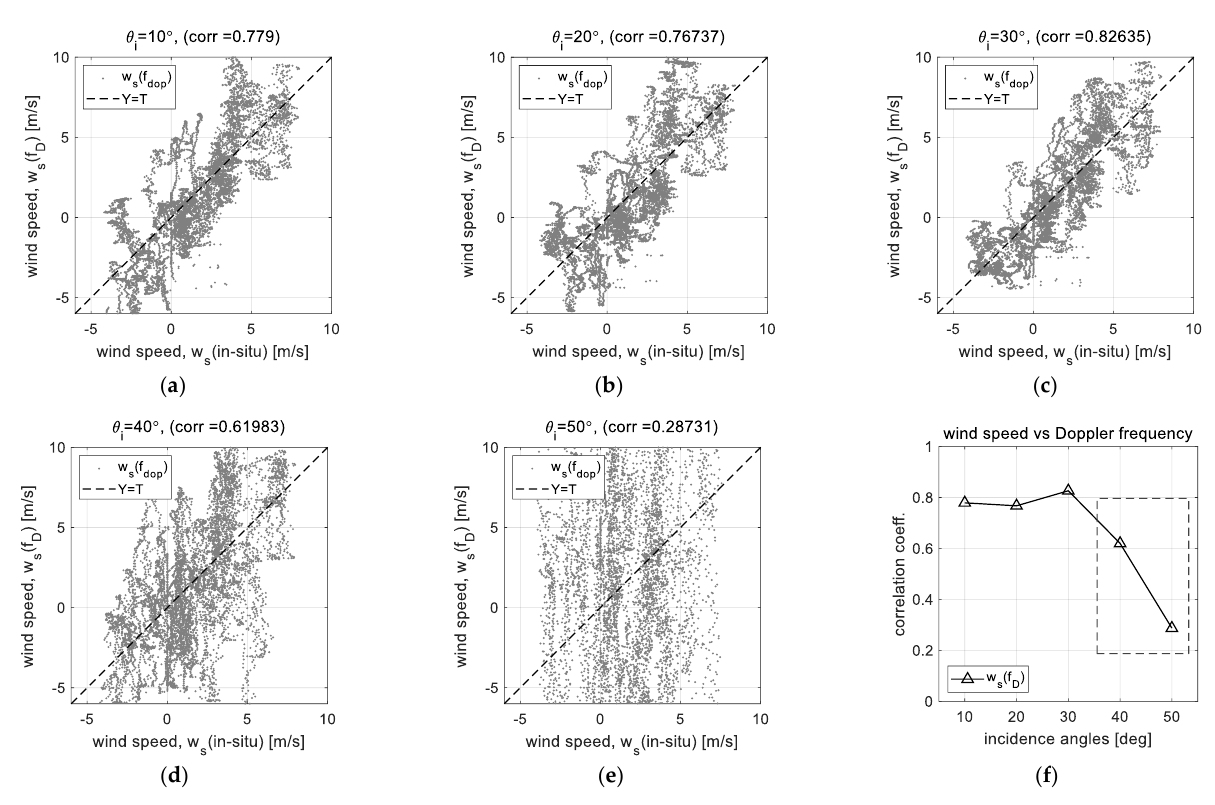
Figure 3. Results of the linear regression analysis of Doppler frequency ( f D ) to wind speed ( w s ): ( a – e ) correlation diagrams at incident angles of 10°~50°, and ( f ) variation of correlation coefficients for each incident angle.